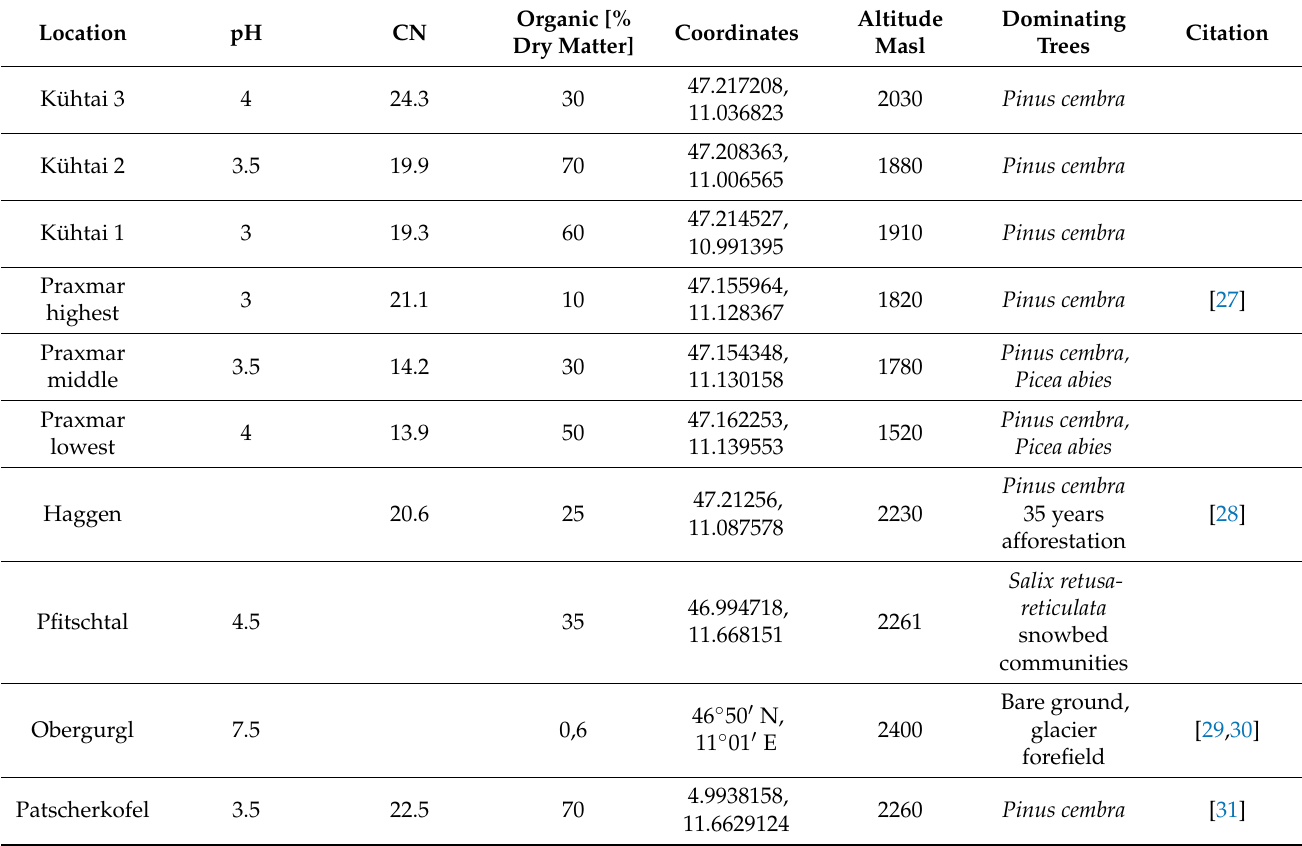
Table 2. Description of sampling sites. The Mortierella s. l. strains were isolated from 10 sites in the Austrian Alps with distinct environmental